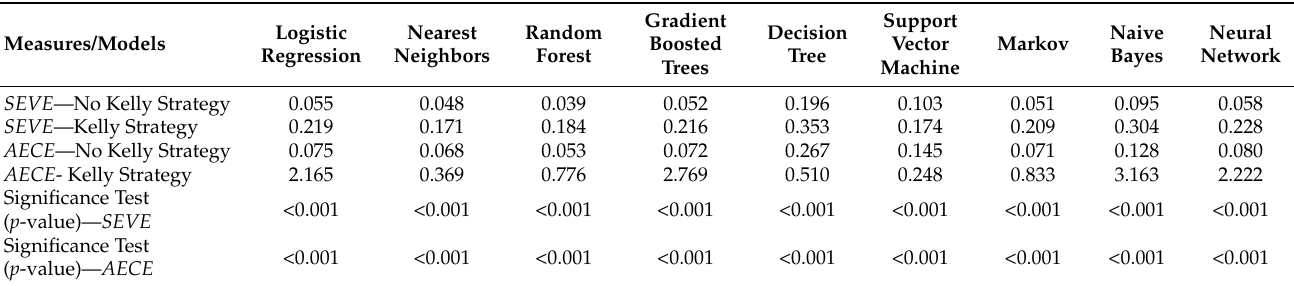
Table 5. Efficiency in processing